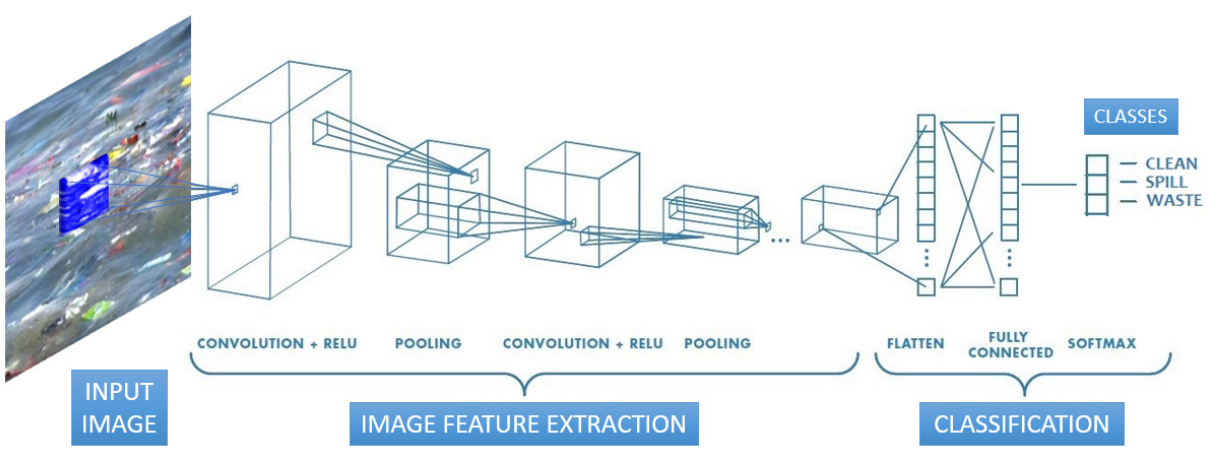
Figure 3. Basic CNN architecture (modified from [26]).